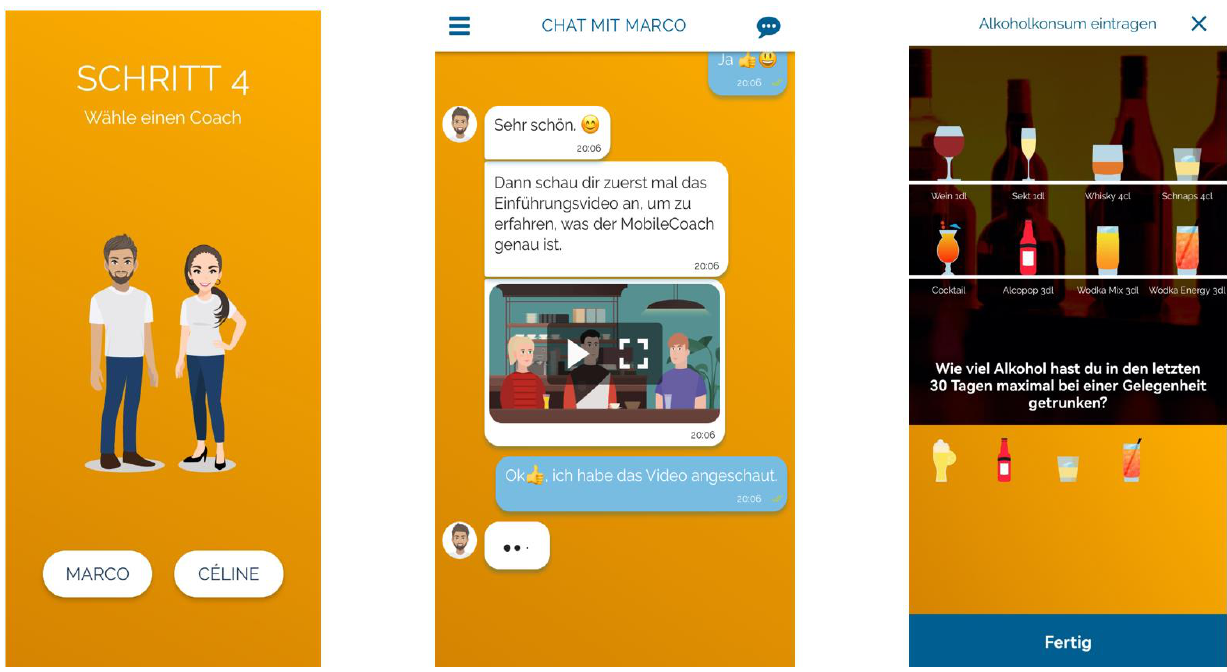
Figure 1. Screenshots from the baseline assessment of the MobileCoach Alcohol program (left: selection of coach; middle: introductory video; right: assessment of alcohol use).